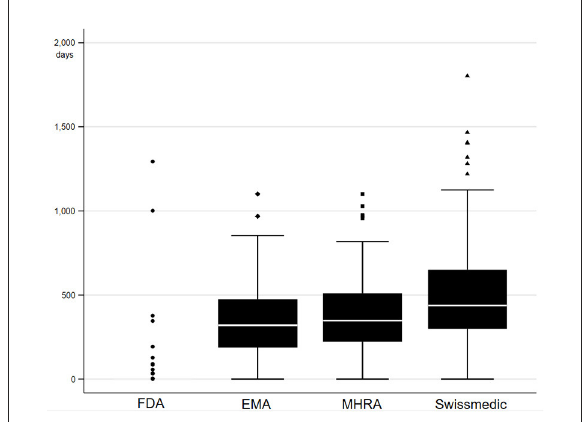
FIGURE2 Drug approval lag in days for novel medicines authorized in 2021. A pool of medicines was created by adding all novel medicines in 2021 as declared by each respective agency considering the same adjustments discussed above (29–31, 33). The pool contained in total 97 medicines, of which 96 were authorized by FDA, 70 were authorized by EMA, 67 were authorized by MHRA, 52 were authorized by Swissmedic, and 45 were authorized by all four agencies. Drug approval lag was defined as the number of days between the first date of authorization by any of the four agencies to date of authorization by each agency. Authorization date was imputed with final day of analysis follow-up (1 August 2022) in case authorization date was not yet available. One outlier was removed, which was characterized by an approval lag above 3,000 days for EMA, MHRA and Swissmedic compared to